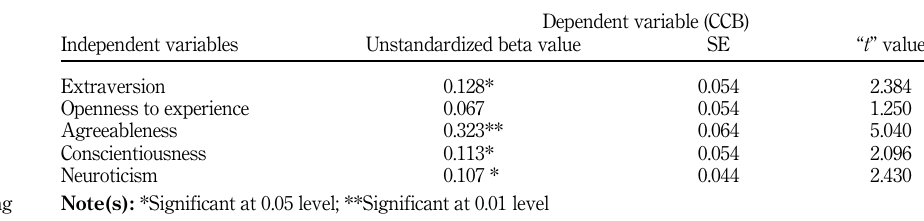
Table 3. The results of hypotheses